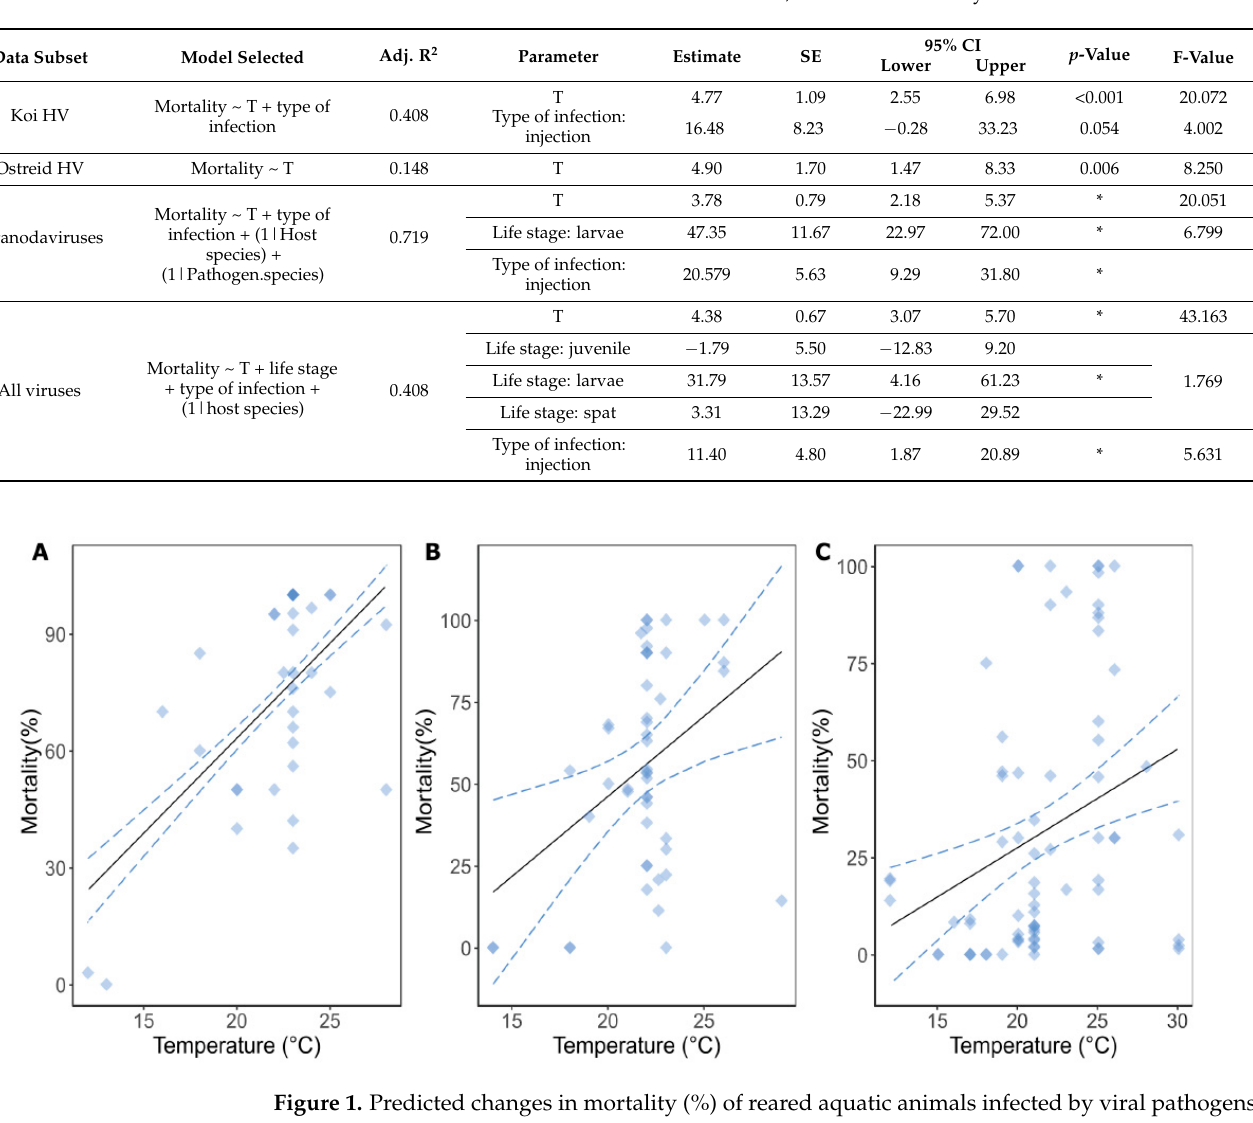
Table 1. Details from the selected linear models (LMs) and linear mixed models (LMMs) to test the relationship between aquatic animal mortality and temperature (T) under viral infections. The p -value is provided for LMs to indicate term significance. In LMMs, a term is considered significant when its 95% confidence interval does not include 0, and is indicated by *.